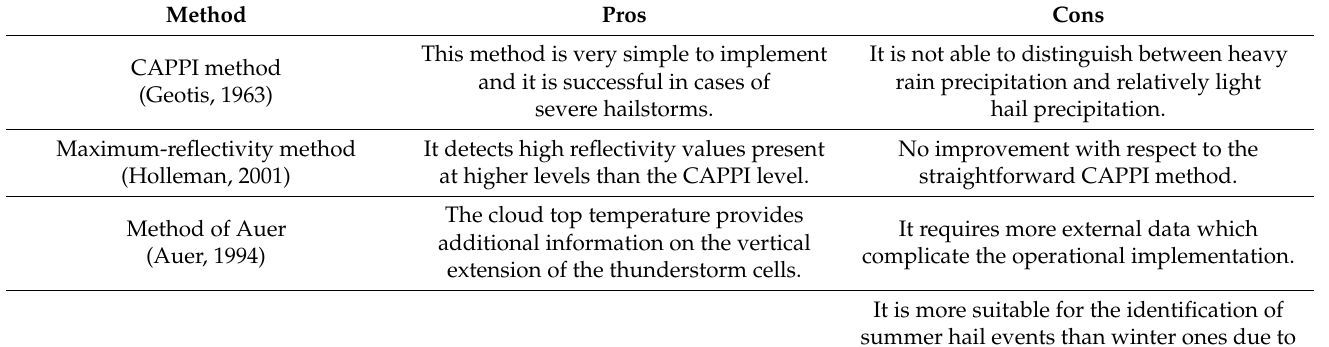
Table 3. Hail detection methods from single-polarization radar measurements proposed in previous studies. For each methodology, the advantages and the disadvantages are briefly